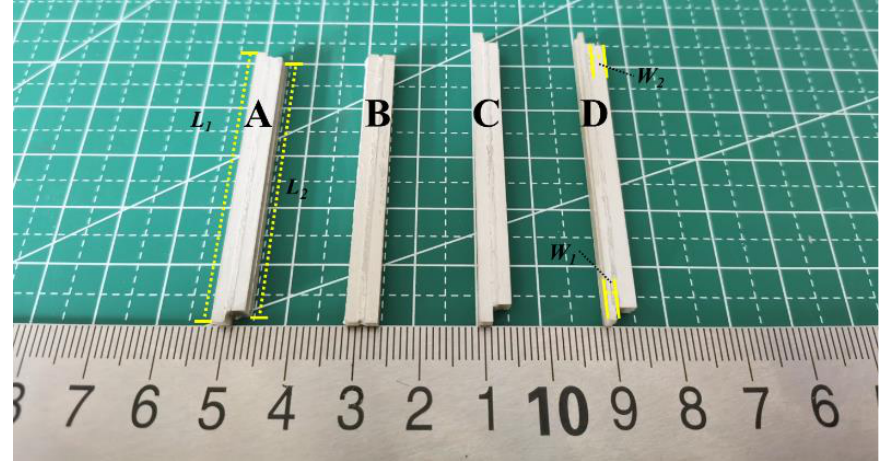
Figure 9. The sample of double-harmonic piezoelectric composite lamination.